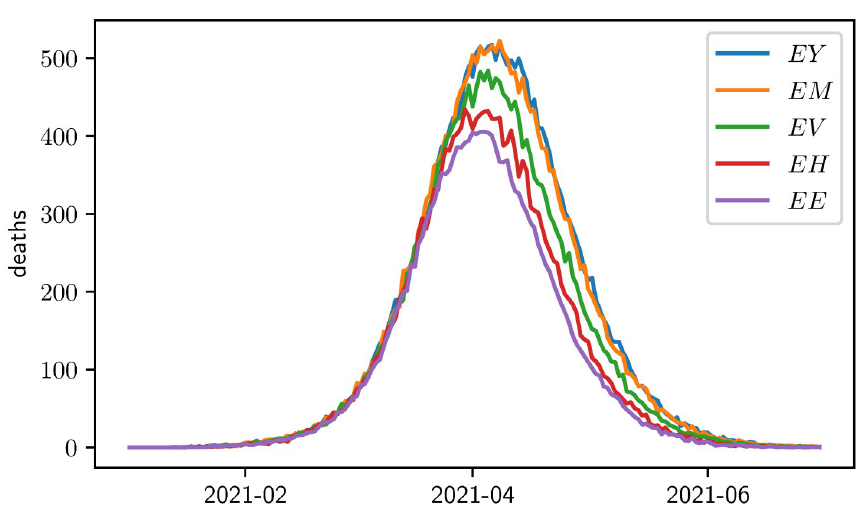
Fig 3. Model results for daily COVID-19 caused deaths for simulations performed during the second step of the optimization algorithm. Each line represents one of the enhancements ð x 0 target variable for the optimization algorithm is the number of cumulative COVID-19 caused deaths.